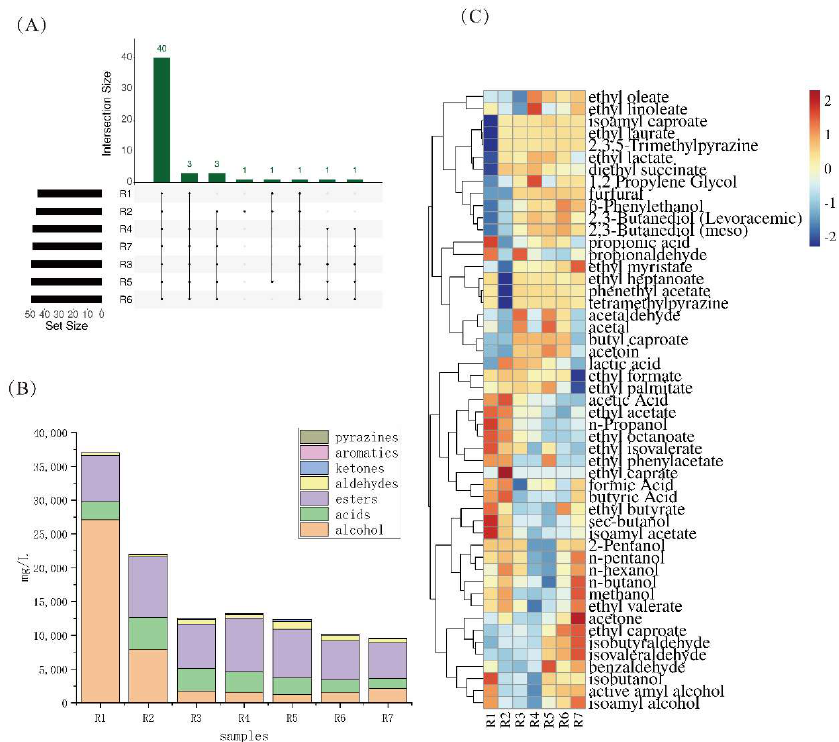
Figure 4. Variation in the flavor content in different rounds of the base Baijiu. ( A ) Advanced Venn Fig.4 diagram analysis of flavor substances in seven rounds. ( B ) Analysis of the composition of flavor substances in base Baijiu. ( C ) Clustering heat map analysis of the change pattern of flavor